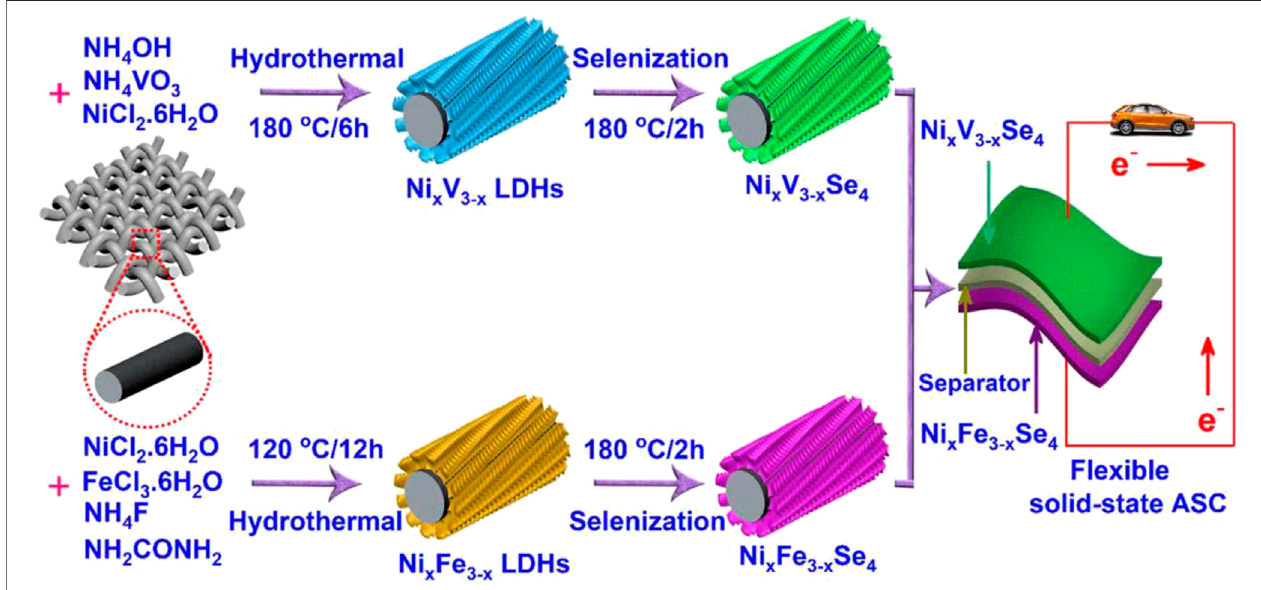
FIGURE 8 | Schematic representation for the design and fabrication of hierarchical Ni x V 3 − x Se 4 and Ni x Fe 3 − x Se 4 nanostructures for solid-state ASCs.